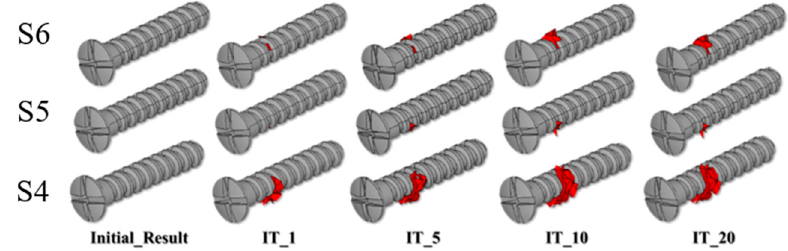
Figure 7. The element death trend around the screw can be represented by the number during the iteration analysis process. Table 3. Dead element number at the initial, first, five, ten, and 20 iterations for all screws.